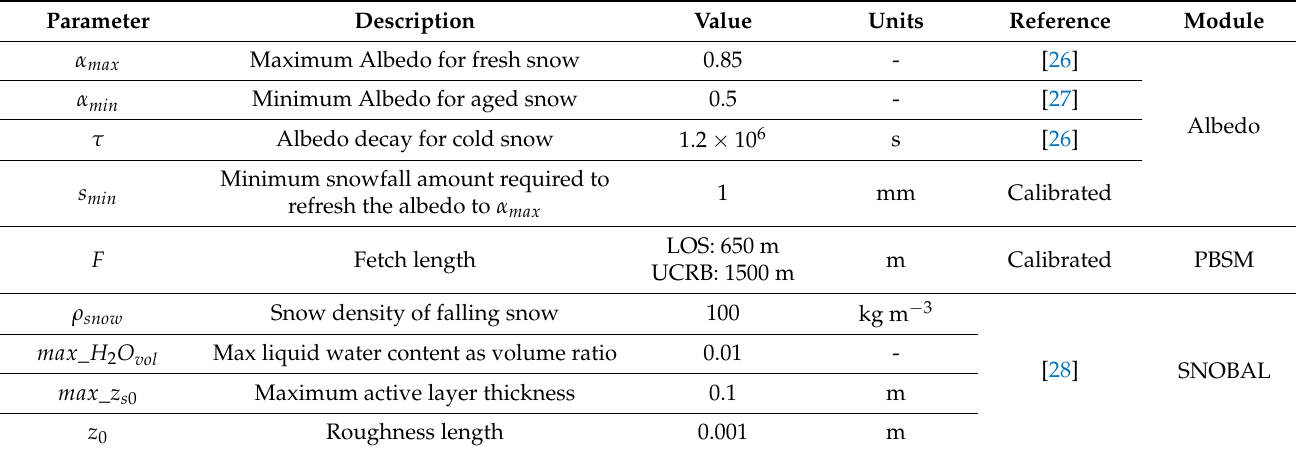
Table 2. Parameters applied in Cold Regions Hydrological Model (CRHM) for the site-scale model and distributed hydrological model. UCRB: Upper Copiap ó River Basin. LOS: La Ollita station.